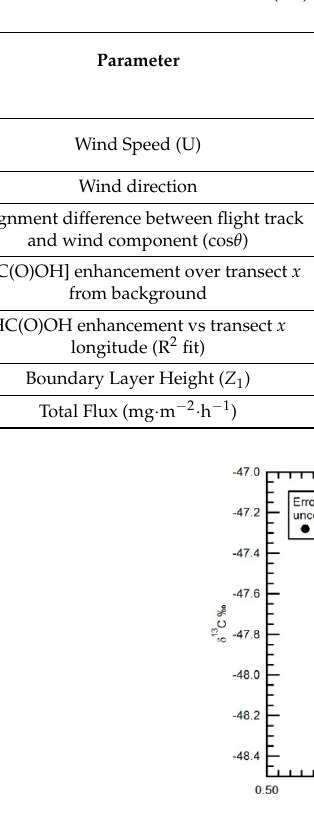
Figure 7. Keeling plot of the WAS data set obtained between 14:40:00 and 15:14:30 during flight B796b and a background sample (10 min prior to transect x ). The y -axis intercept gives the isotopic signature of the “added” methane over the background.